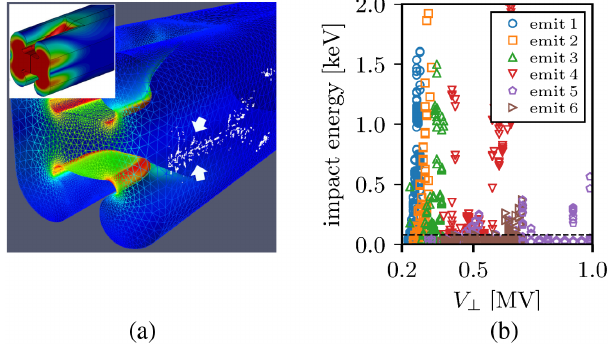
FIG. 14. First multipacting barrier at V ⊥ ¼ 0 . 2 − 0 . 7 MV. (a) Electric field at the cavity surface with the resonant particles trajectories after 70 rf cycles (white). (b) Corresponding impact energies for different initial emitter locations. The simulations are carried out using ACE 3 P .